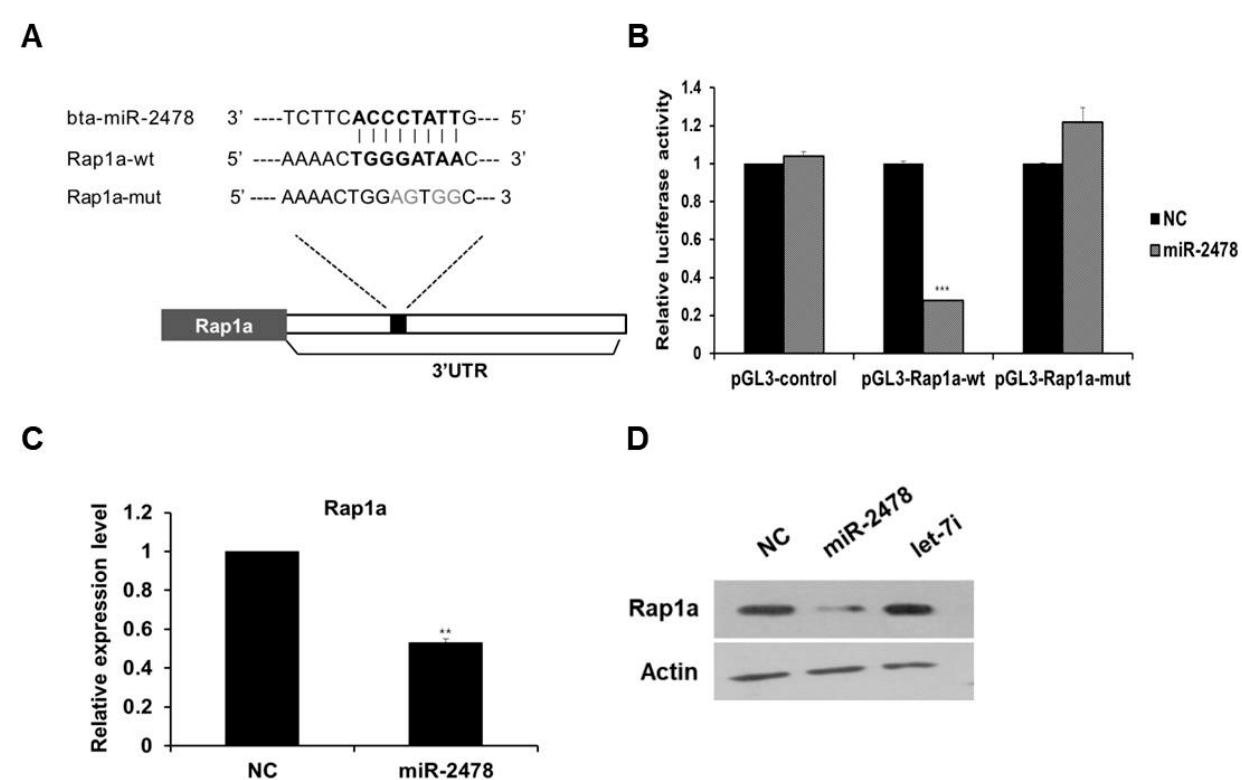
Figure 5. Rap1a is targeted by miR-2478. ( A ) Sequence alignment of a putative binding site for miR-2478 in the 3 (cid:48) UTR of Rap1a mRNA. The putative binding site in the Rap1a 3 (cid:48) UTR region was then mutated. ( B ) Cos7 cells were cotransfected with either the miR-2478 mimic or a negative control (NC) for 48 h and either a wild-type 3 (cid:48) UTR reporter plasmids(pGL3-Rap1a-wt) or a mutant 3 (cid:48) UTR plasmid (pGL3-Rap1a-mut). Luciferase activity was assayed at 48 h post-transfection; n = 3, *** p < 0.001. ( C , D ) Levels of Rap1a expression in B16F10 cells transfected with either the miR-2478 mimic or NC were measured by qRT-PCR and Western blotting; n = 3, ** p < 0.01.